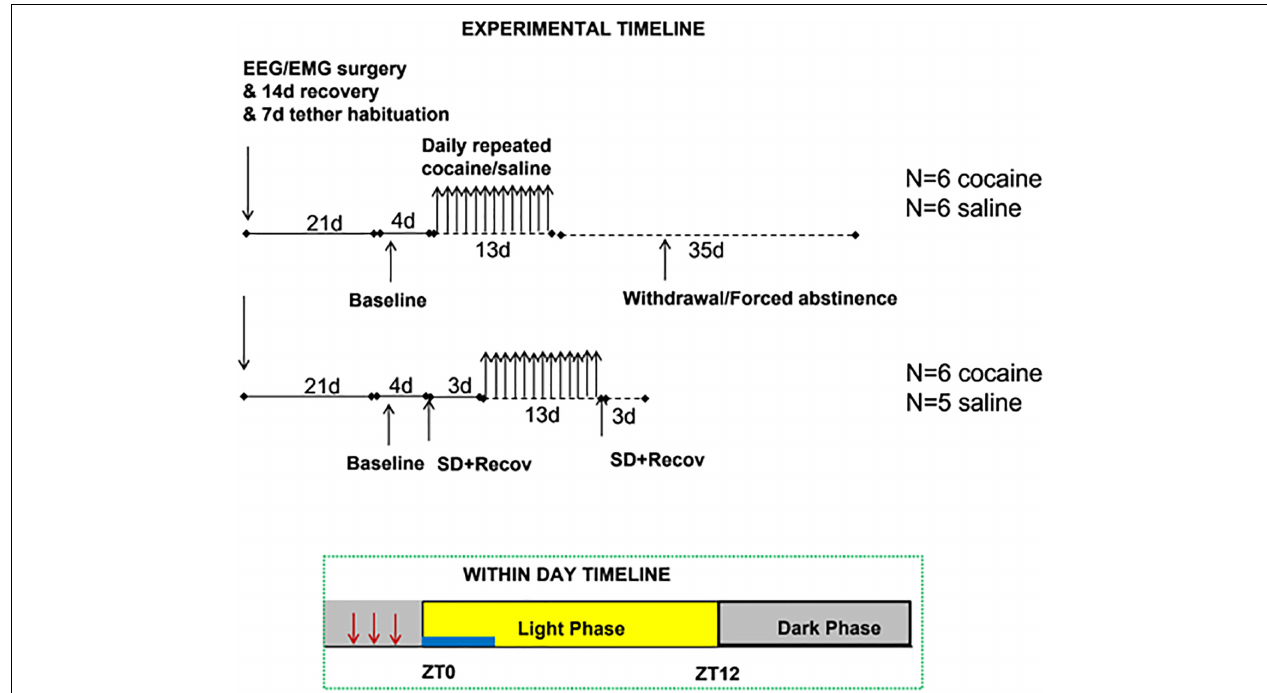
FIGURE 1 | Experimental timeline: [Top] consisted of surgical implantation and recovery followed by baseline, cocaine/saline exposure (injection period), and 35 days forced abstinence (post-injection period), [Bottom] consisted of the same surgical implantation and recovery, followed by baseline, 4 h SD and recovery [Pre], cocaine/saline exposure, and a second 4 h SD and recovery [Post]. The timing of injections (indicated by red arrows) and SD (indicated by blue bar) relative to the light/dark cycle is given in the within day timeline. The light phase is indicated by the yellow box and the dark phase by the gray boxes.